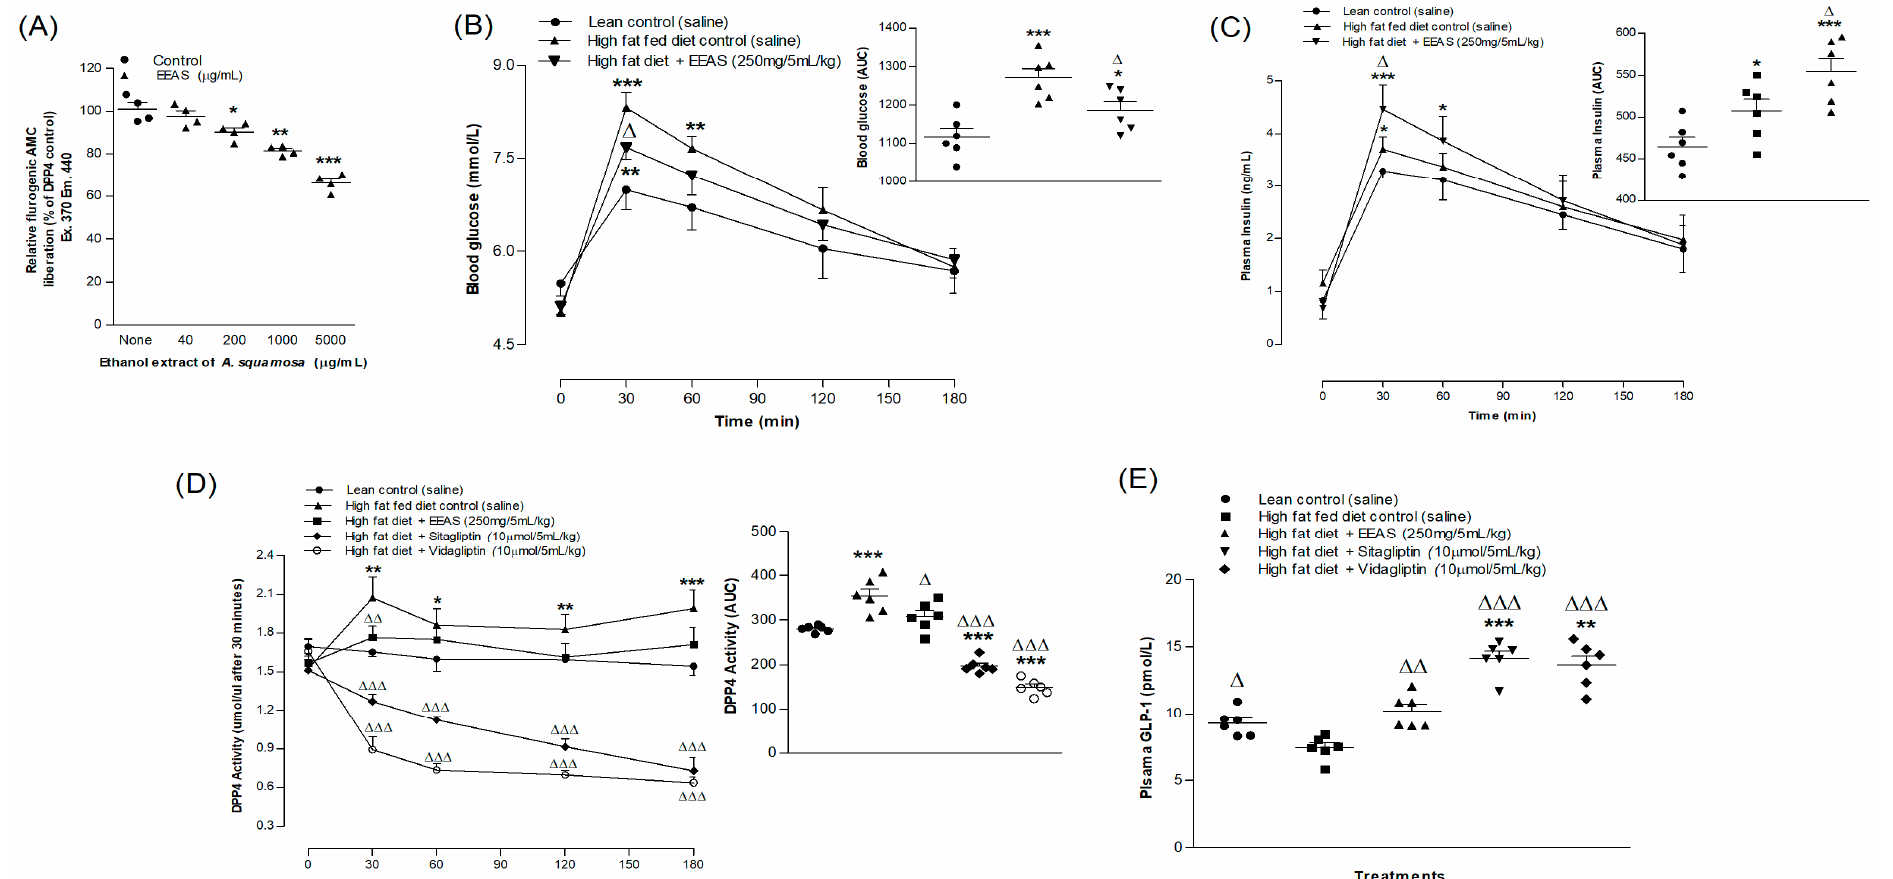
Figure 3. Effects of EEAS on ( A ) DPP-IV enzyme in vitro, ( B ) glucose tolerance, ( C ) plasma insulin, ( D ) DPP-IV, and ( E ) active GLP-1 (7-36) in high-fat-fed rats. In vivo parameters were evaluated before and after oral gavage of glucose alone (18 mmol/kg body weight (b.w.), control) or with EEAS (250 mg/5 mL/kg b.w.), sitagliptin and vidagliptin (both at 10 µmol/5 mL/kg b.w.). Plasma active GLP-1 (7-36) levels was assayed at 30 min after treatments. Values n = 4 for in vitro DPP-IV enzyme activity and n = 6 for in vivo parameters are mean ± SEM. *, **, *** p < 0.05–0.001 compared to control. Δ , ΔΔ , ΔΔΔ p < 0.05–0.001 compared to high-fat-fed diet control rats.